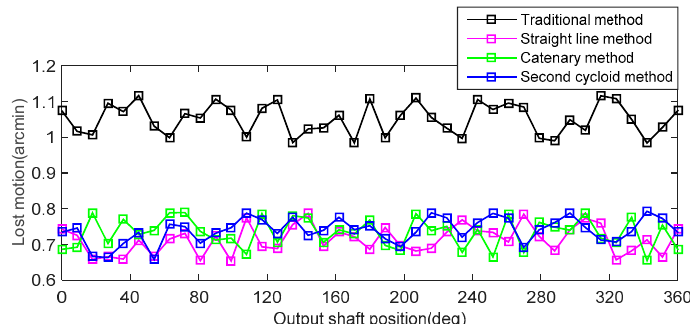
Figure 16. Geometric lost motion based on actual measurements.